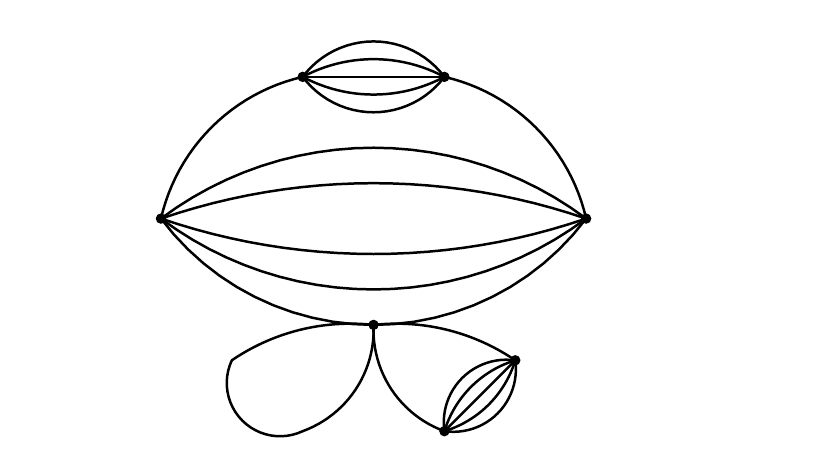
Figure 1. 4-colored graph corresponding to a two-loop Feynman diagram with external tensor contractions equivalent to I 2 .